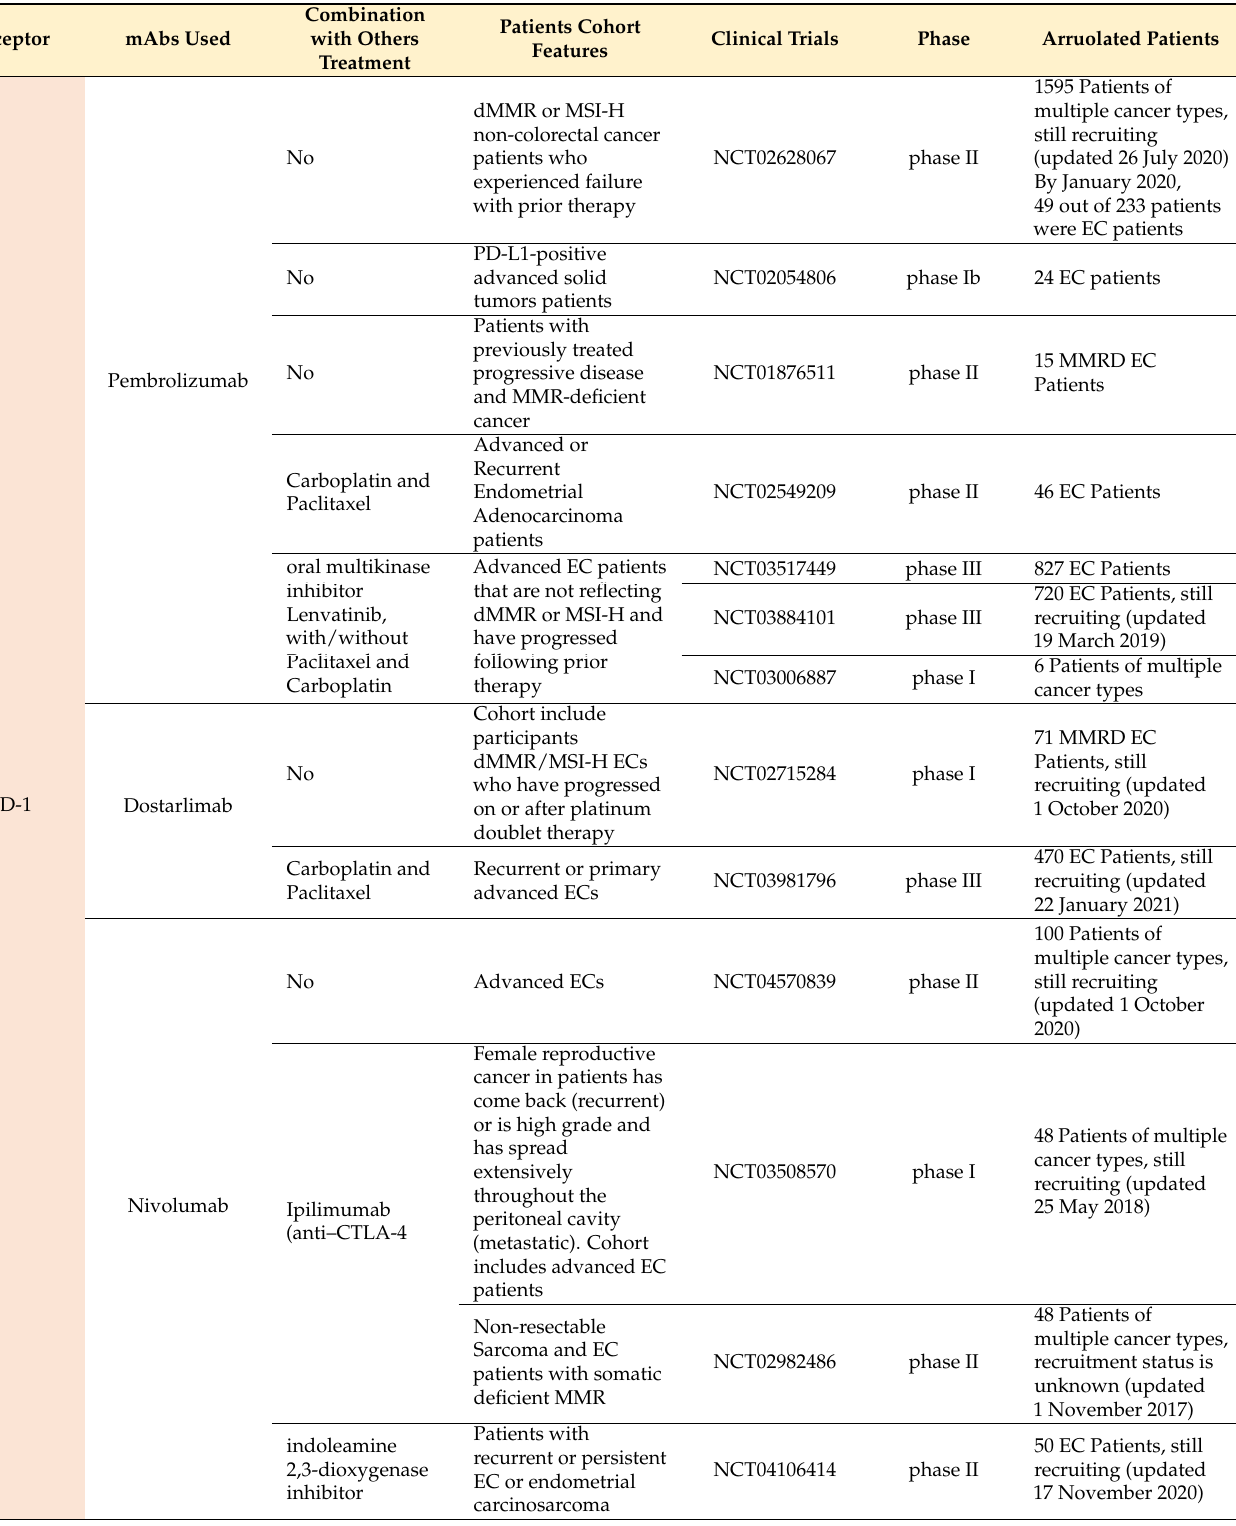
Table 1. Active clinical trials for EC with anti-PD-1 or PDL-1 monoclonal antibodies (mAbs). Receptor mAbs